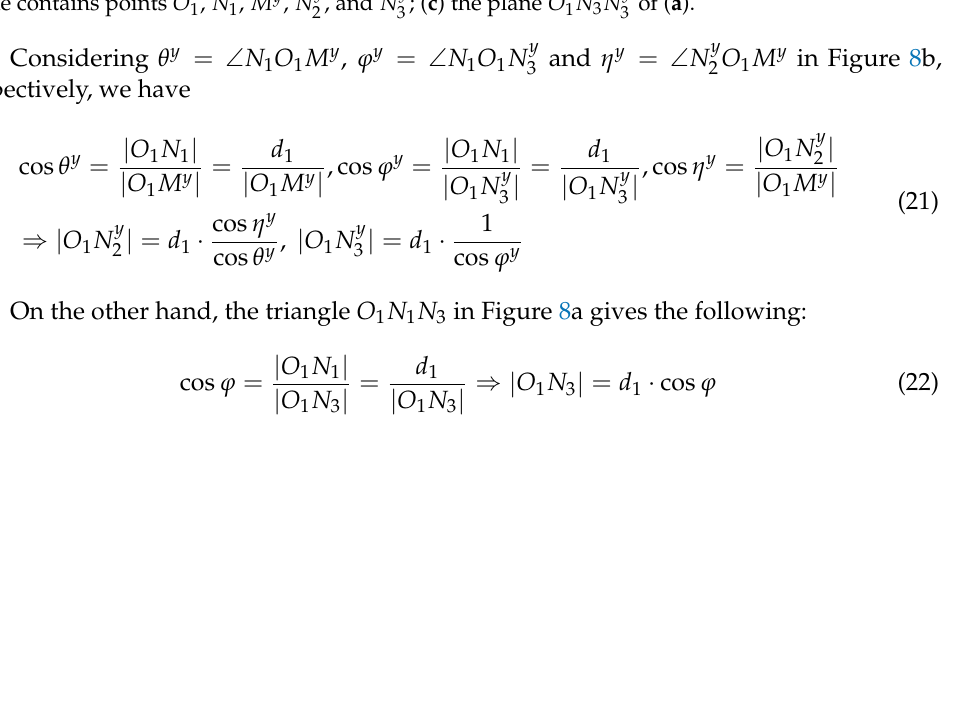
, and N y ; ( c ) the plane O 1 N 3 N y of ( a 2 3 3